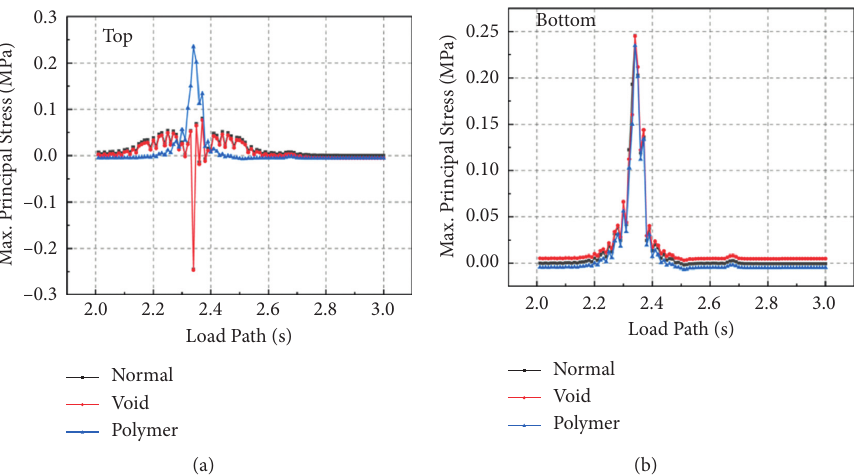
Figure 12: Time-history response curve of maximum principal stress at the slab corner directly above void area: (a) at slab top and (b) at slab bottom.